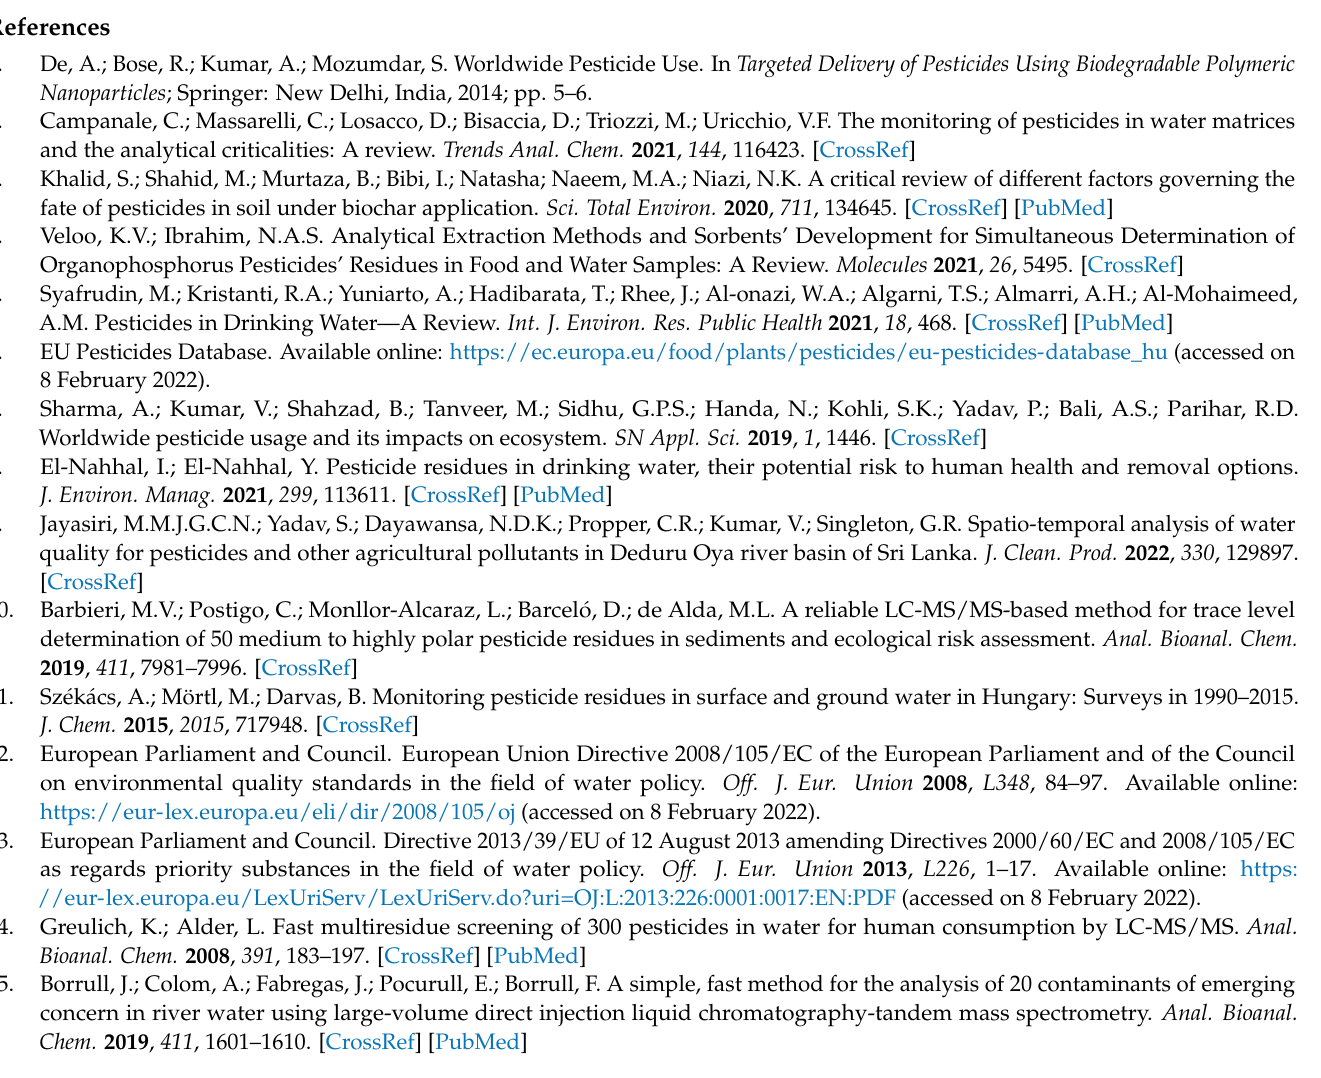
groundwater; Figure S4: Recovery (%) versus retention time (min) at 100 ng/L in surface water; Figure S5: Precision (%) versus retention time (min) at 100 ng/L in surface water; Table S1: The scheduled MRM ion transitions of the tested 480 pesticides; Table S2: (a): Validation data for 330 pesticides in groundwater; (b): Validation data for 330 pesticides in surface water; Table S3: Recovery% and precision (RSD%) in groundwater at 10 ng/L spiking level using automated SPE enrichment; Table S4: Results of real sample